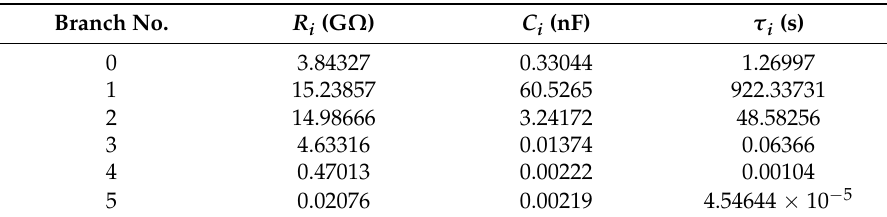
Table 4. The identified resistance and capacitance in EDM at 80 ◦